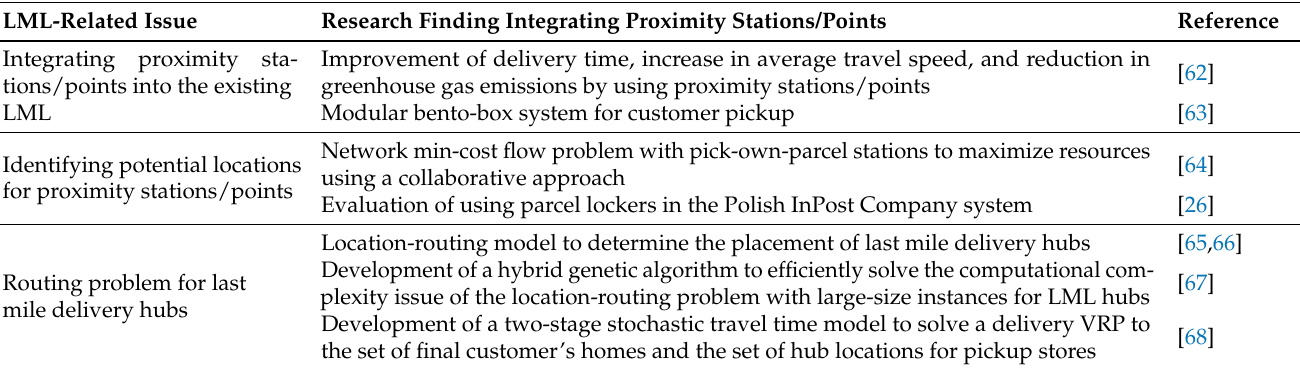
Table 4. LML-related issues and research findings: Proximity stations/points and